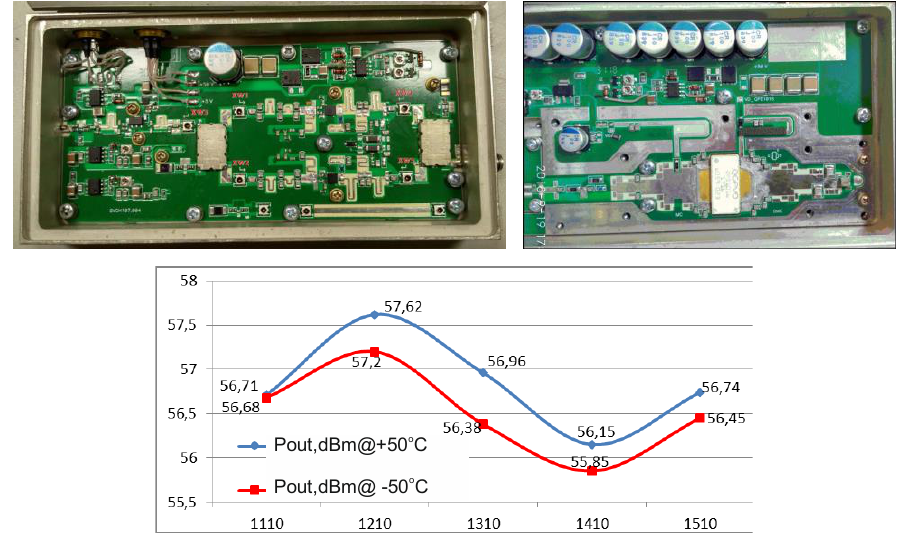
Fig. 3. L-band power amplifier view : input stages (left top), output stage (right top) and frequency characteristics of output power at standard termocycle (bottom).